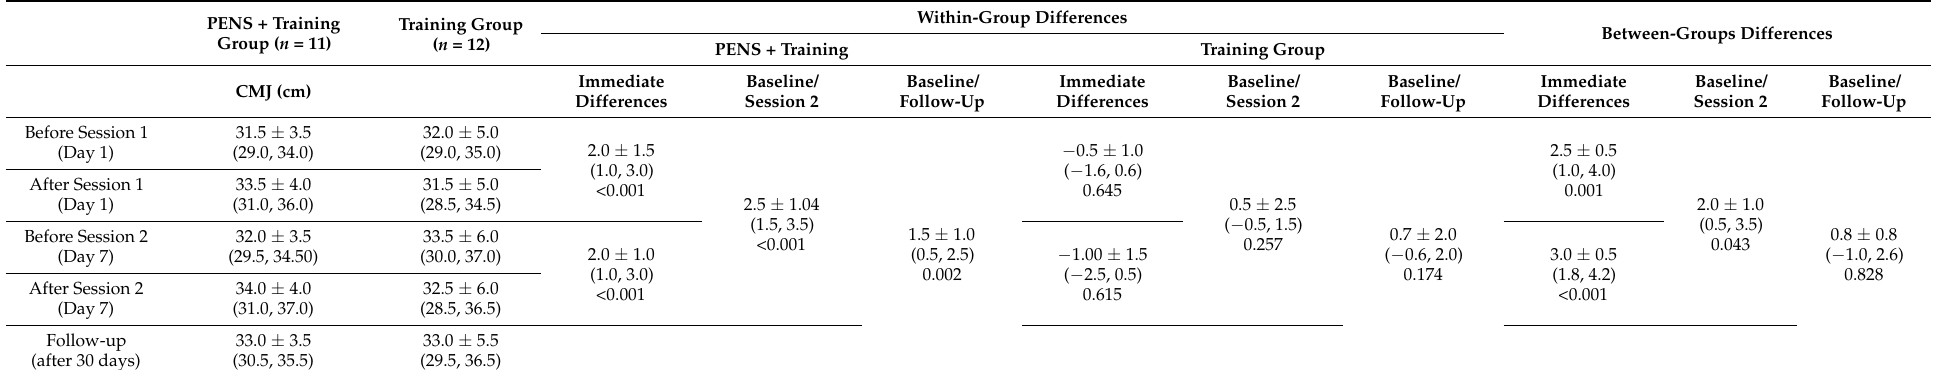
Table 3. Timeline scores, within-group, and between-group changes of the vertical jump height during Countermovement jump